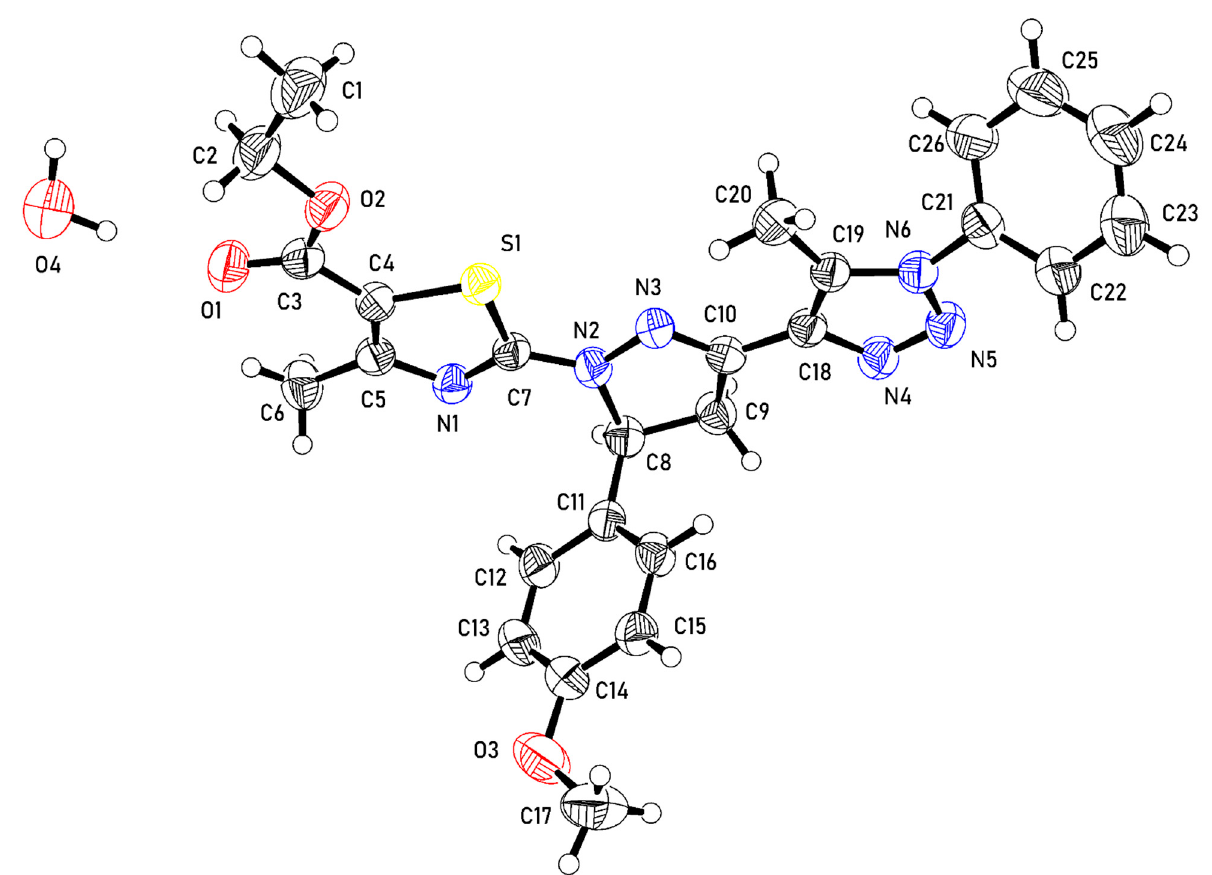
Figure 3. An ortep representation of 8 showing 50% probability atomic displacement ellipsoids.